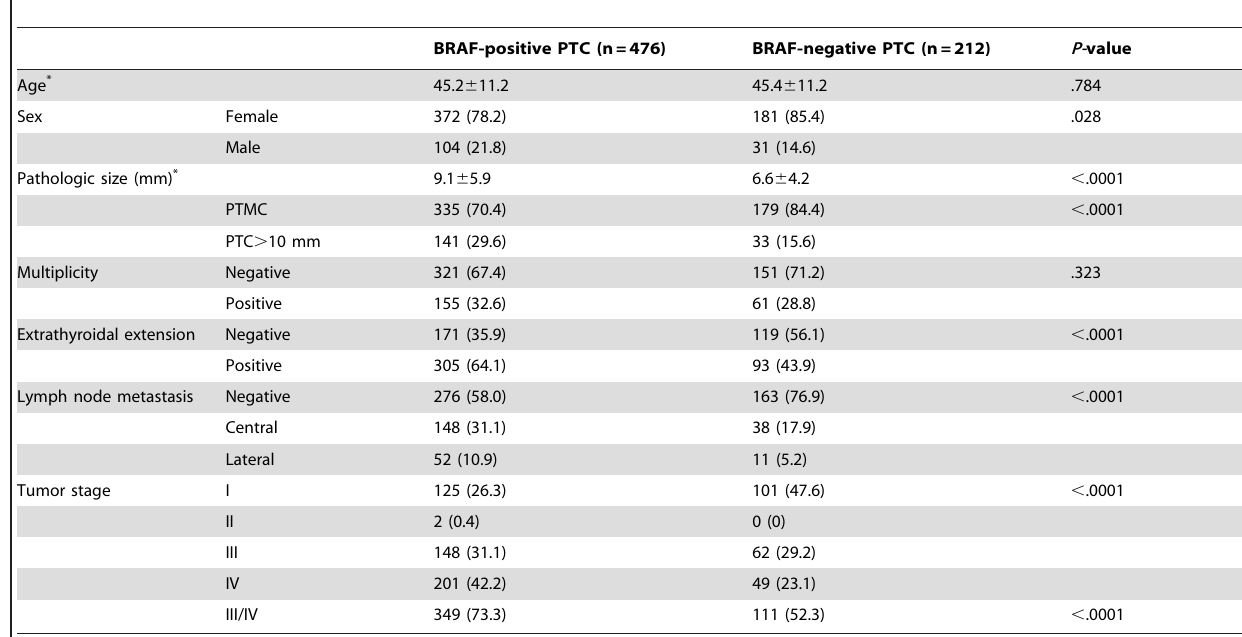
Table 3. Association of the BRAF V600E mutation with clinicopathologic characteristics of patients with